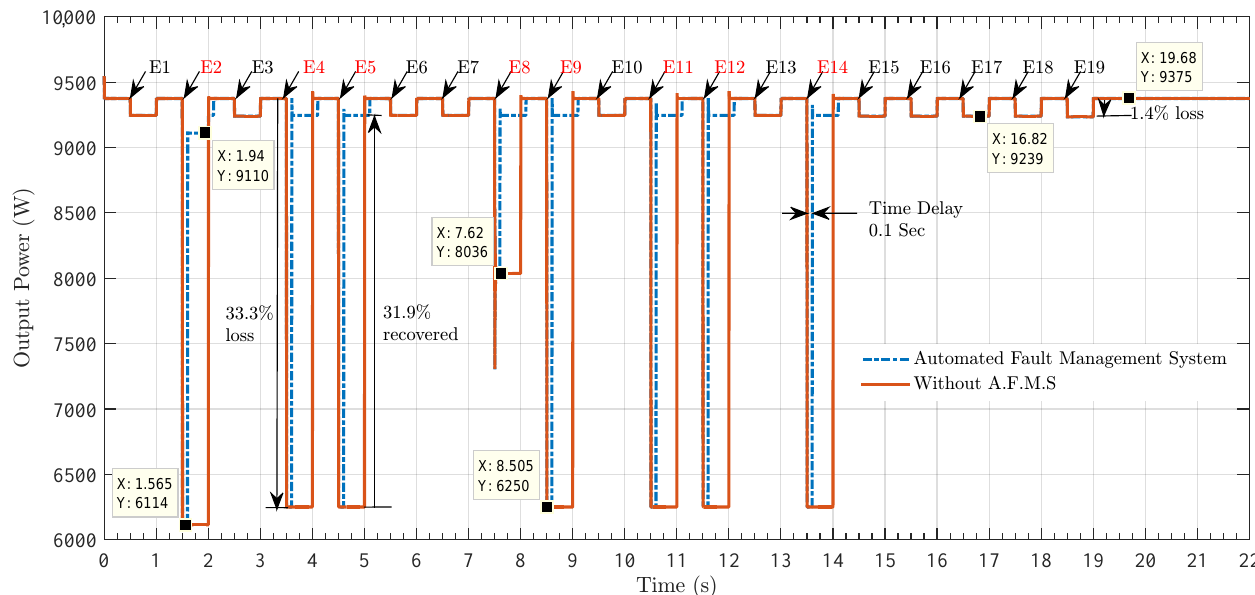
Figure 9. The behavior of the output power with different electrical faults in the 16 × 3 PV